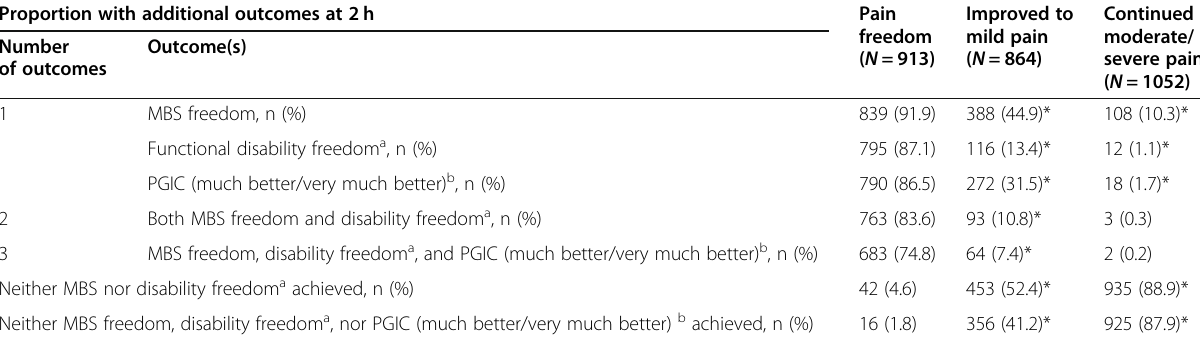
Table 3 Coexistence of positive outcome(s) with head pain outcome at 2 h Proportion with additional outcomes at 2 h Pain